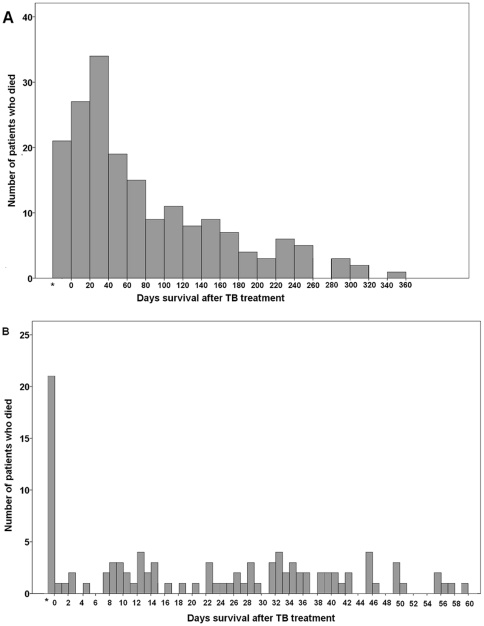
Survival time of pulmonary tuberculosis patients after initiation of anti-TB treatment.(A) within one year. (B) within 60 days. * Number of cases died before initiation of anti-TB treatment.